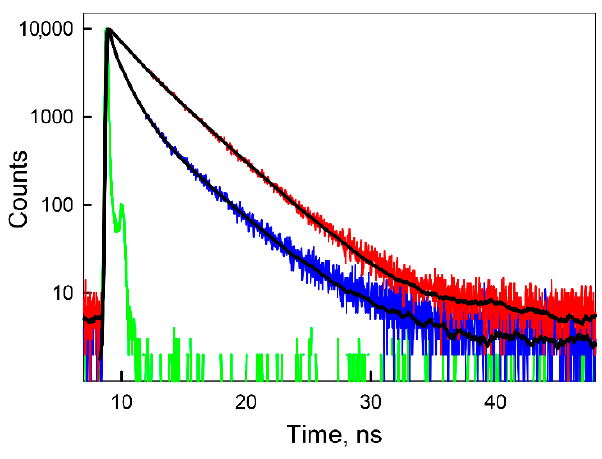
Figure 3. The fluorescence decay of BADAN bound to GGBP/H152C in apo (blue curve) and holoform (red curve) in semilogariphmic scale. The green curve represents the instrument response function. The best fits of BADAN decay are represented by black curves. The excitation wavelength was 372 nm.